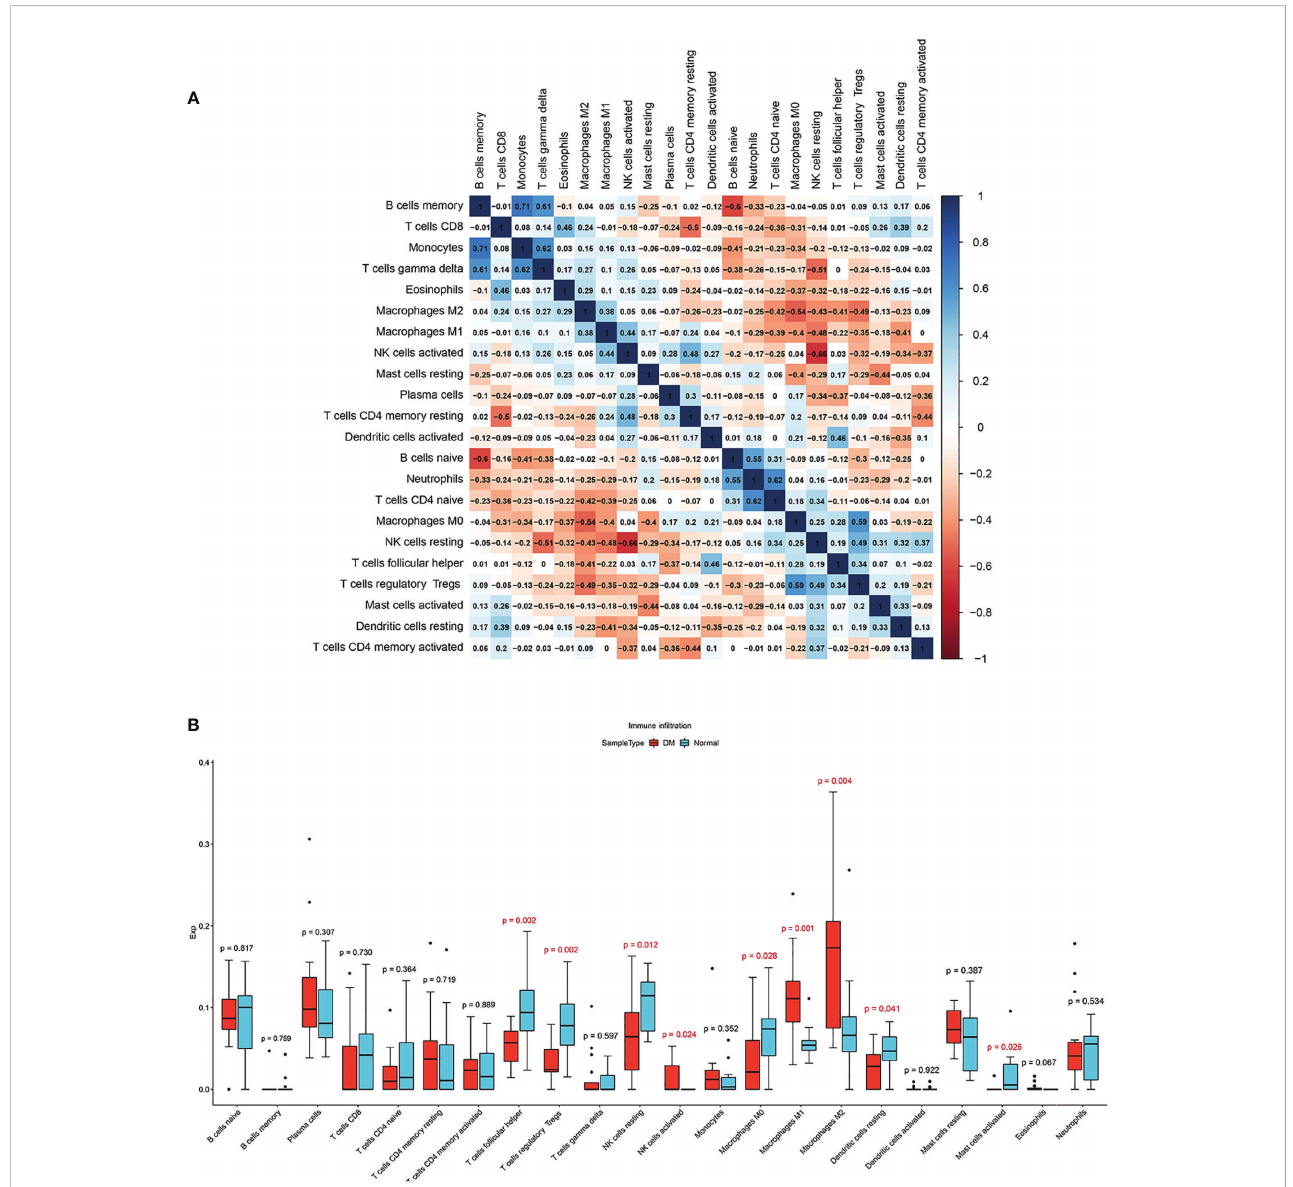
FIGURE 6 (A) Correlation heatmap among 22 types of in fi ltrating immune cells. (B) Box plot of differences of 22 immune in fi ltrating cells. Normal and DM groups are represented by blue and red,